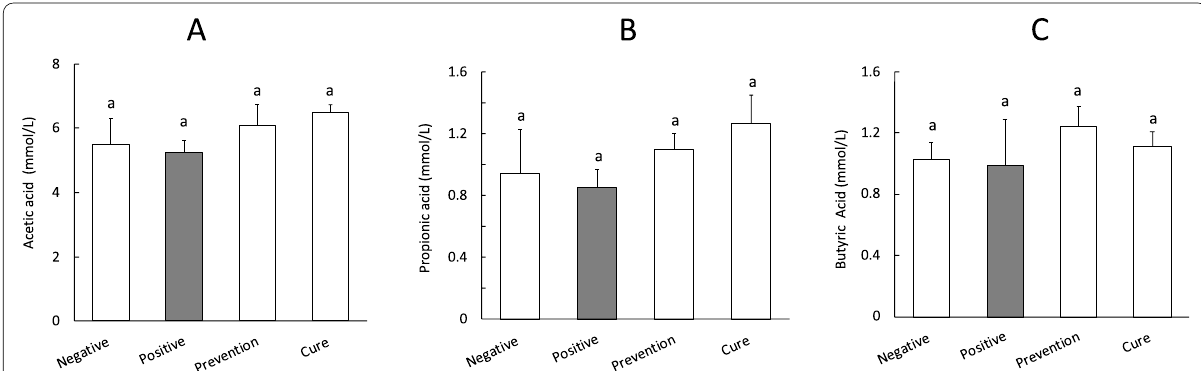
Fig. 5 Short chain fatty acid profiles in the cecal contents of Citrobacter rodentium -infected and non-infected mice, some of which were subjected to immobilized L. plantarum intervention. Levels of ( A ) Acetic acid; ( B ) Butyric Acid and ( C ) Propionic Acid slightly increased with Lactobacillus plantarum intervention. a means with the same letters within a particular SCFA are not significantly different ( p <